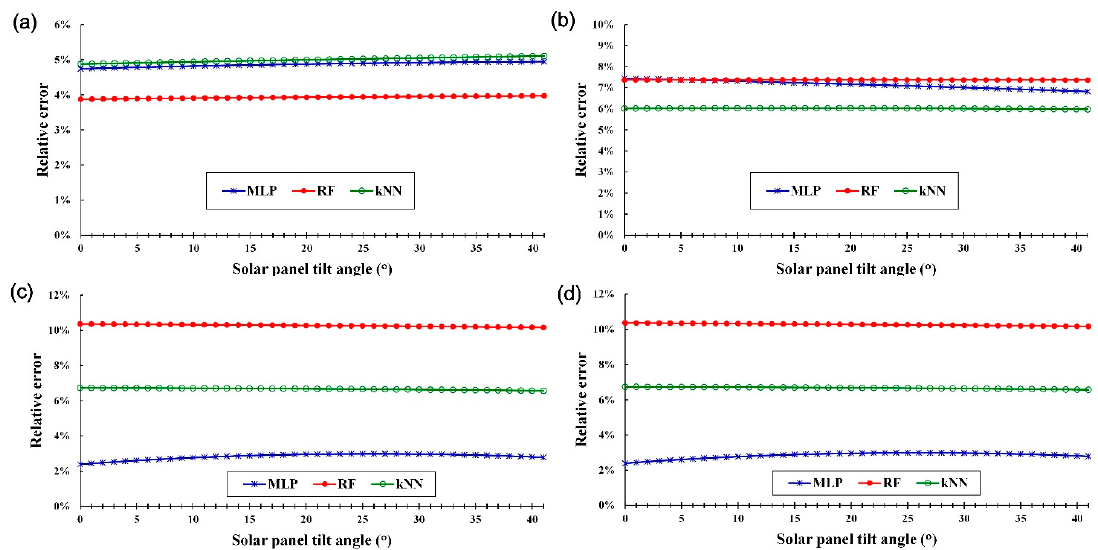
Figure 17. Relative error of the predicted total annual global irradiance within ( a ) t + 1, ( b ) t + 3, ( c ) t + 6, and ( d ) t + 12.